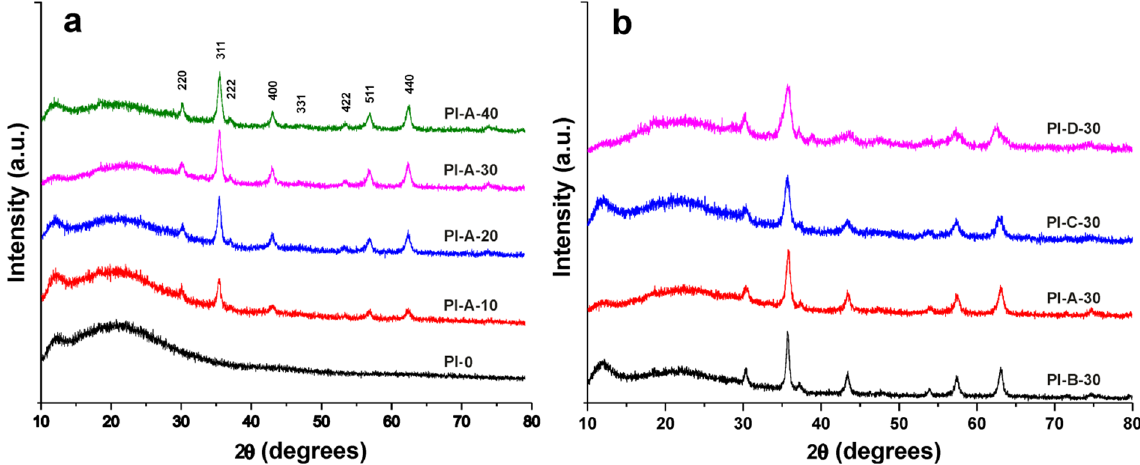
Figure 3. XRD patterns of PI-0, PI-A-10, PI-A-20, PI-A-30, and PI-A-40 ( a ) and PI-A-30, PI-B-30, PI-C-30, and PI-D-30 ( b ).